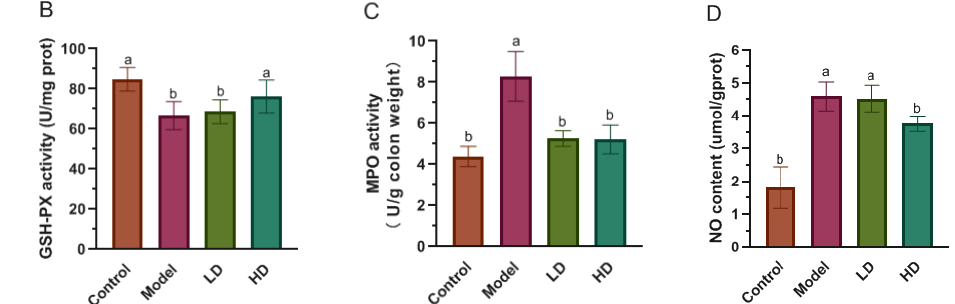
Figure 3. Effect of FBPE on the inflammatory mediators in the mice colon with DSS-induced colitis. SOD activity ( A ), GSH-Px activity ( B ), MPO activity ( C ) and NO content ( D ). Different lower-case letters correspond to a significant difference at p < 0.05.